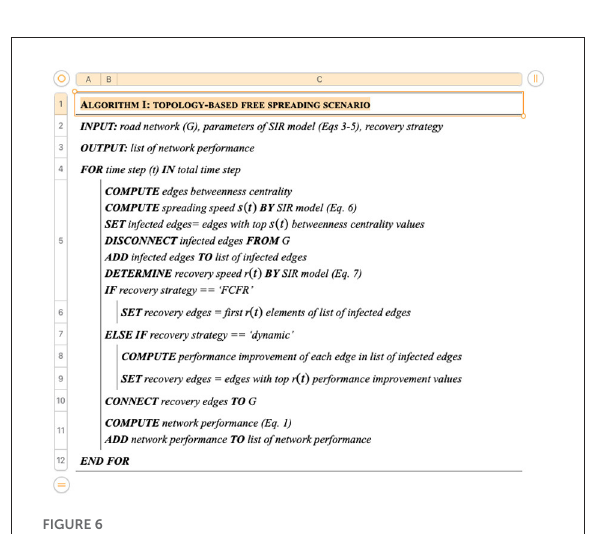
FIGURE7 Algorithm II: Trajectory-based spreading